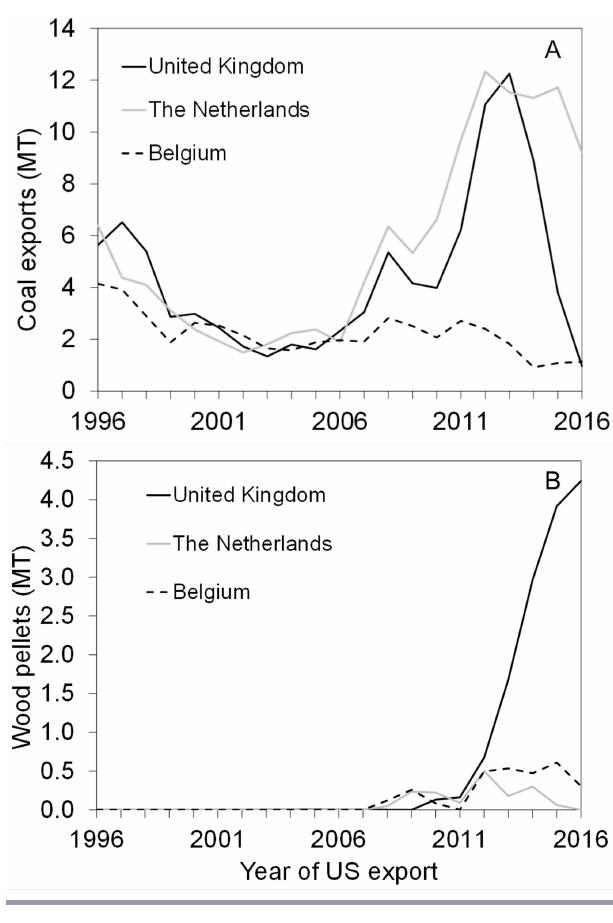
Fig. 4. (A) U.S. coal exports to the three largest European importers of Southeast U.S. (SE US) wood pellets, namely the UK, the Netherlands, and Belgium (USITC 2017). (B) SE US wood pellet exports to these three European Union member states (USITC 2017) accelerated at about the same time that U. S. coal exports began to slow or decline. However, the decline in U.S. coal exports to Europe has resulted from factors additional to increased wood pellet use.